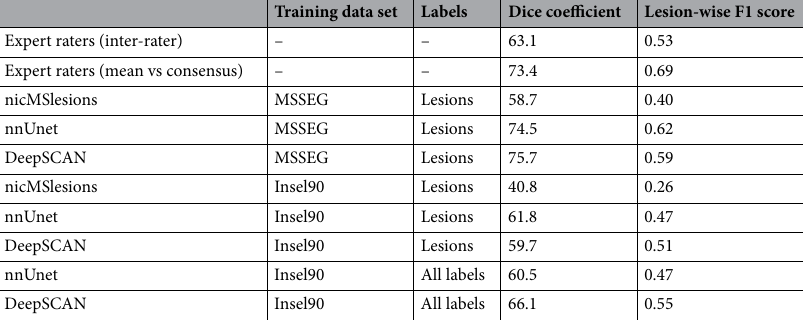
Table 3. Segmentation and lesion detection metrics against the MSSEG LOP-STAPLE consensus.